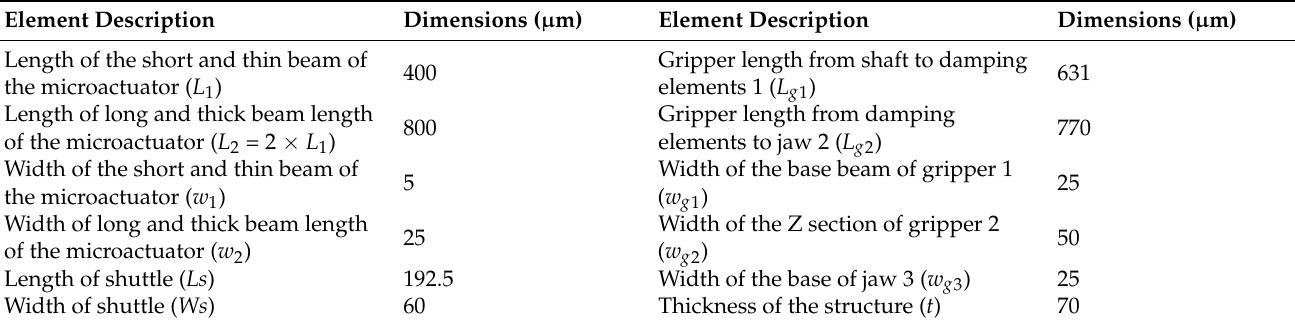
Table 4. Geometrical parameters of the microgripper